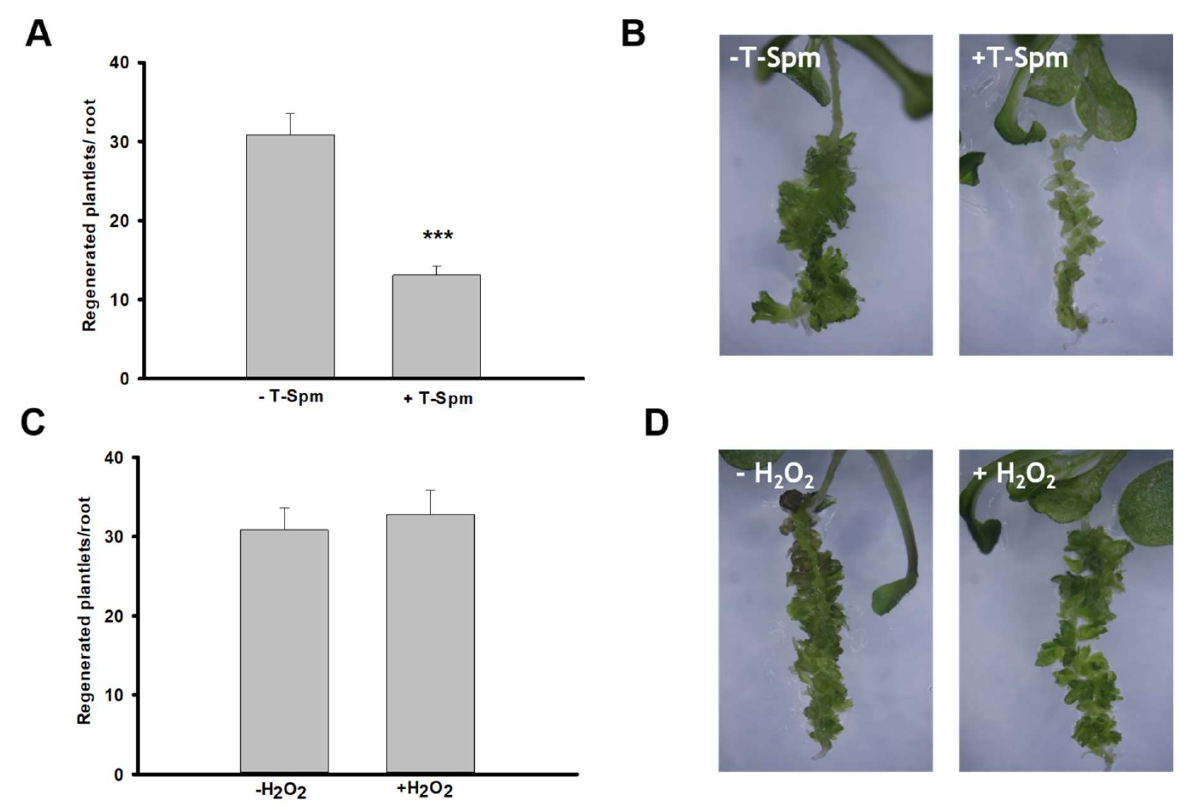
Figure 2. Conversion of lateral root primordia to shoot meristem is affected by exogenous T-Spm but not by H 2 O 2 . ( A ) Effect of exogenously applied T-Spm (+T-Spm) on the shoot regeneration efficiency of untreated WT seedling roots ( − T-Spm) after 10 days of cytokinin induction. ( B ) Representative images of shoot-regenerating roots used for the calculation shown in A. ( C ) Effect of exogenously applied 100 µM H 2 O 2 (+H 2 O 2 ) on the shoot regeneration efficiency of untreated WT seedling roots ( − H 2 O 2 ) under the same conditions as in A. ( D ) Representative images of shoot regenerating roots used for the calculation shown in C. In A and C, data are means ± SE of three biological replicates with twenty technical replicates each. For significance analysis Student’s T-test was used. (*** p ≤ 0.001).